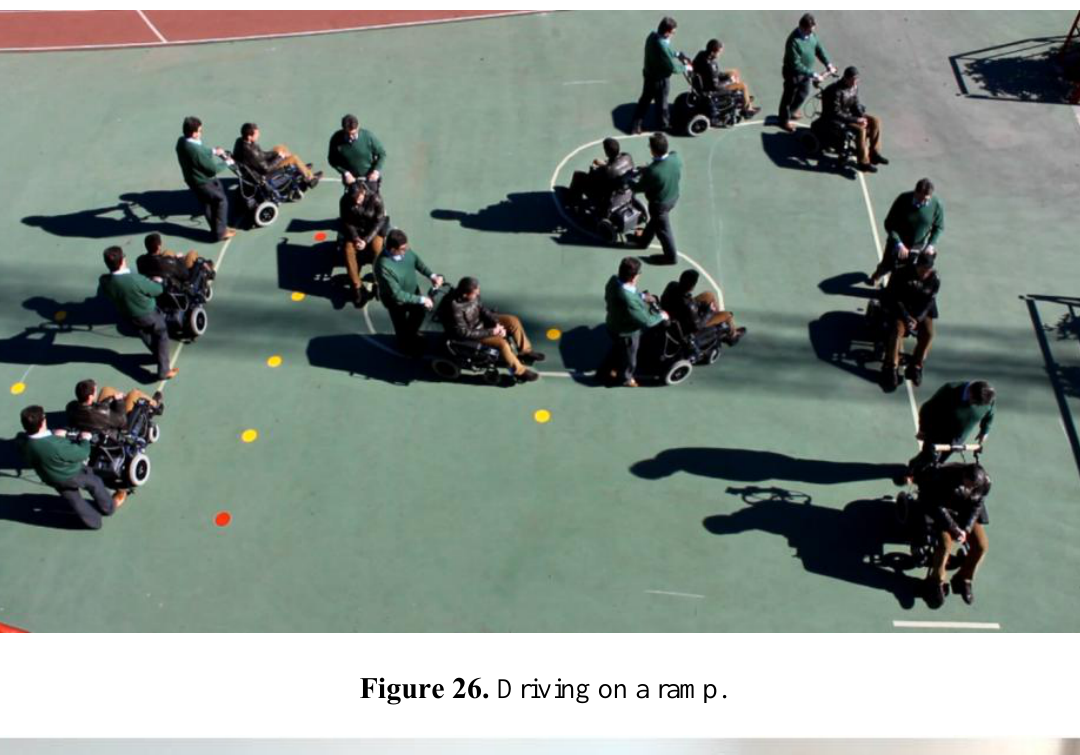
Figure 25. Test path: sixth user.